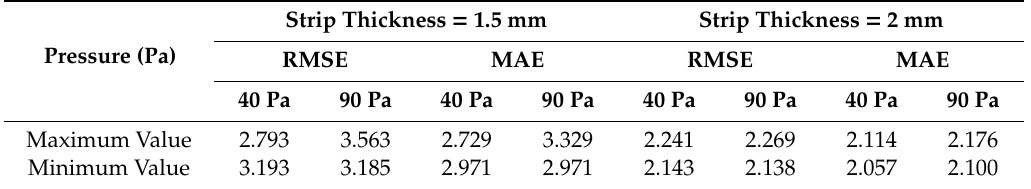
Table 3. Prediction results of the maximum and minimum height in the vibration